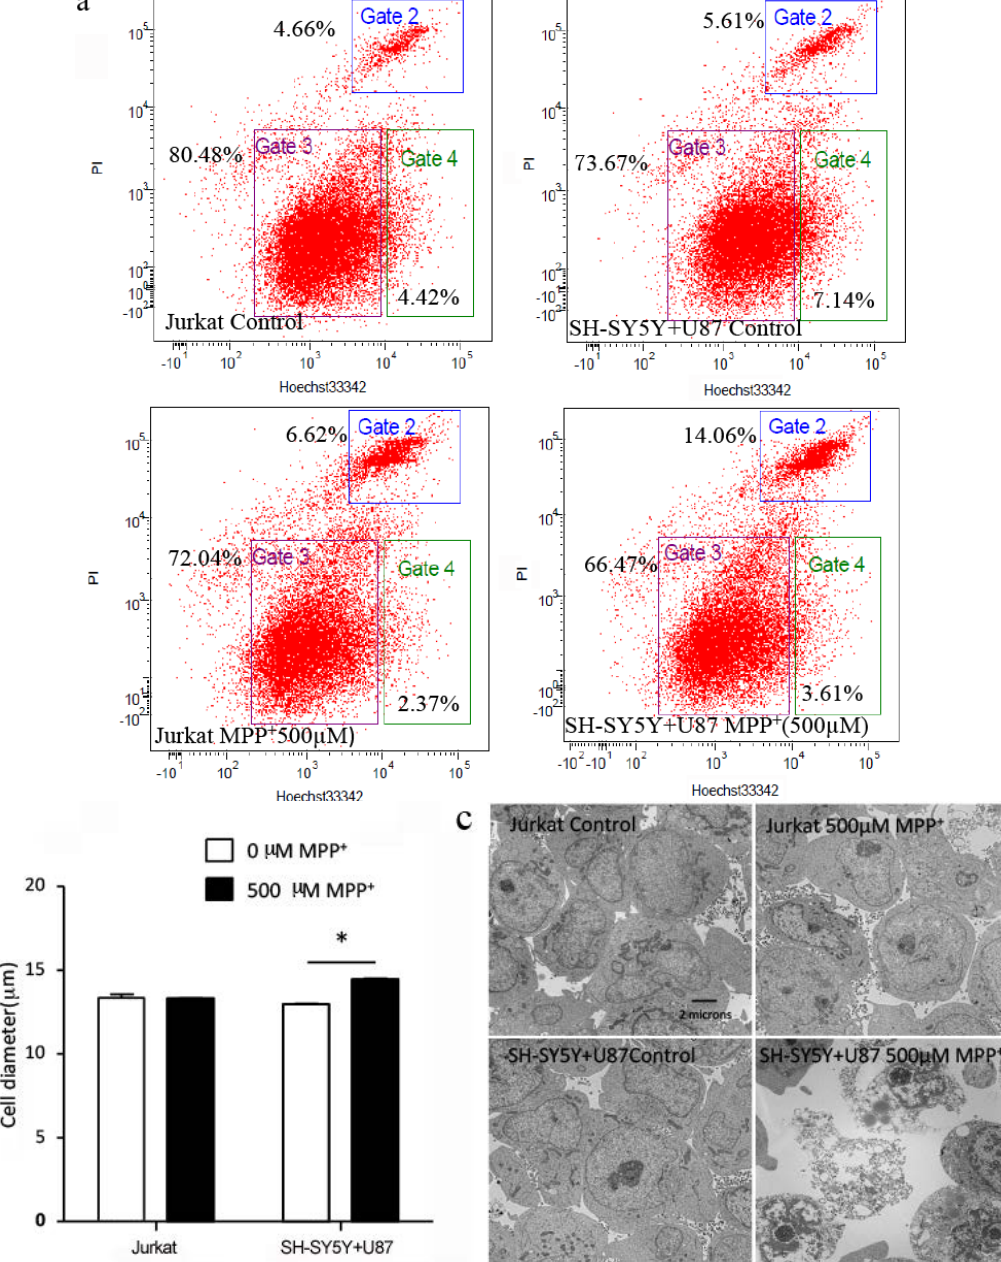
Figure 4. Five hundred micro mole per liter MPP + -treated co-culture medium of SH-SY5Y and U87 cells induced Jurkat cells necrosis. Jurkat cells treated with or without MPP + as background control; Jurkat cells incubated with the conditioned media of co-culture system treating without MPP + as control. ( a ) Fluorescence activating cell sort (FACS) assay for necrosis of Jurkat cells in MPP + -treated co-culture medium. Left channel showed Jurkat cells treated with or without MPP + ; right channel showed Jurkat cells incubated with the conditioned media of co-culture system treating with or without MPP + . Cells in Gate 2 represent for necrosis, Gate 4 for apoptosis and Gate 3 for live cells. PI, Propidium iodide; ( b ) The changes of Jurkat cell diameter in MPP + -treated co-culture medium. * p < 0.05 compared with Jurkat cells in co-culture medium without MPP + ; ( c ) Electro microscopy assay for Jurkat cell membrane damage in MPP + -treated co-culture